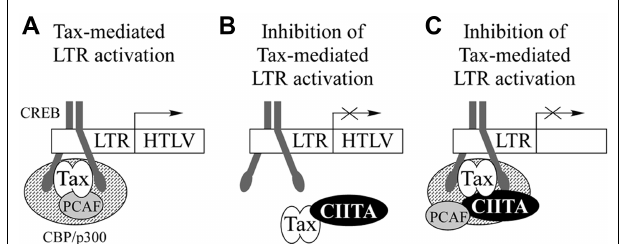
FIGURE 3 | CIITA-Tax interaction might differently affectTax-mediated activation of the viral LTR promoter. (A) In the absence of CIITA,Tax-1 is recruited by CREB to the viral LTR and promote the formation of an higher order multiprotein complex activating transcription. (B) CIITA bindsTax and prevents its recruitment to the LTR promoter. (C) Tax bound to CIITA is recruited to the LTR, but its transcription function is impaired.